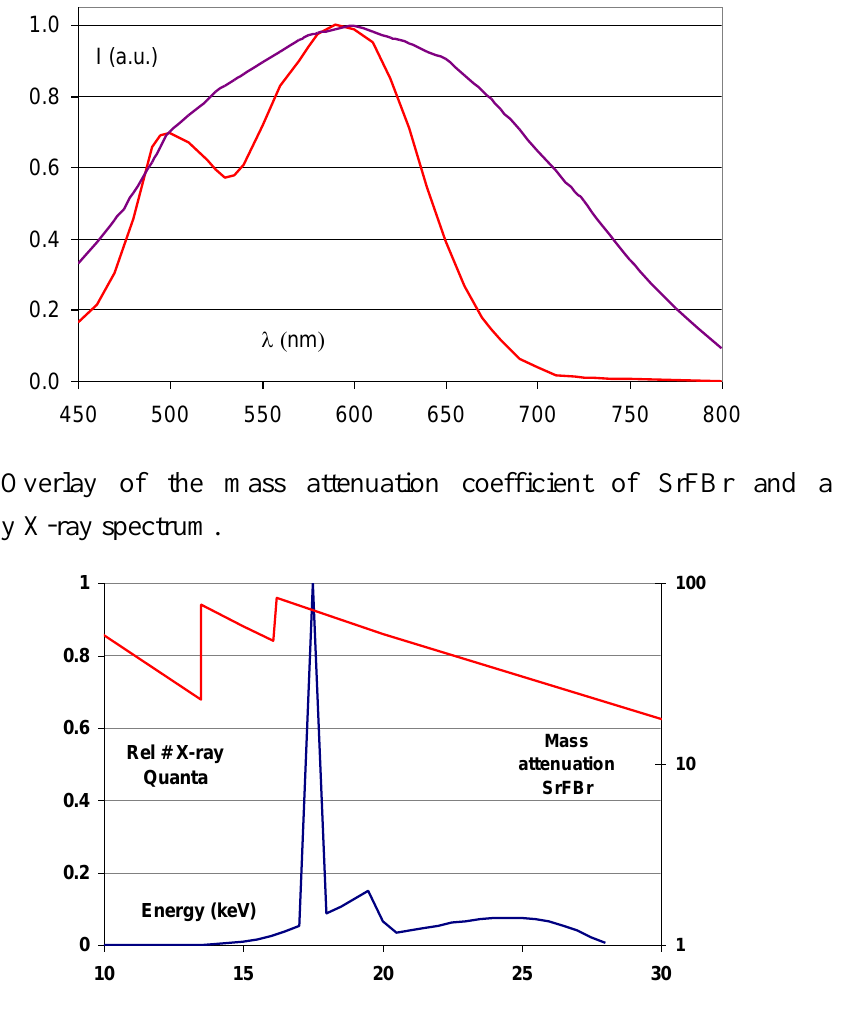
Ca FBr:Eu 2+ (purple) (data from [39]) and 0.99 0.01